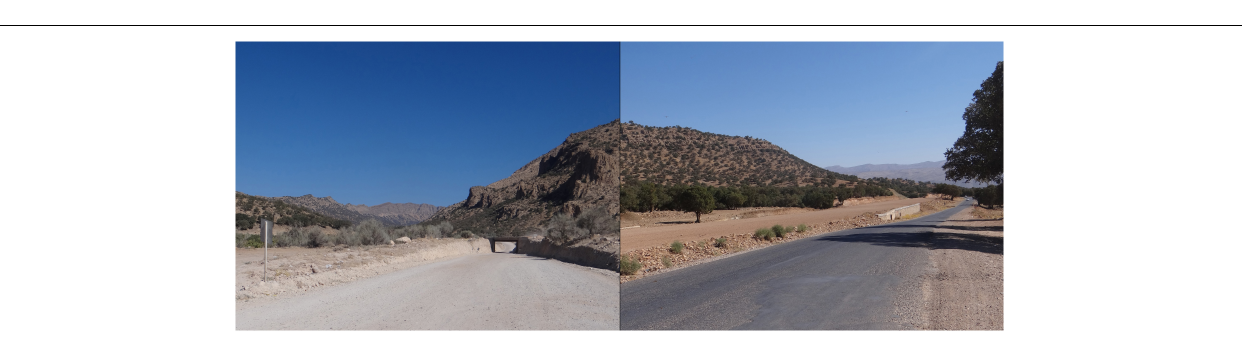
FIGURE 2 | Sections of the highway passing through the Tang-e-Bostanak Protected